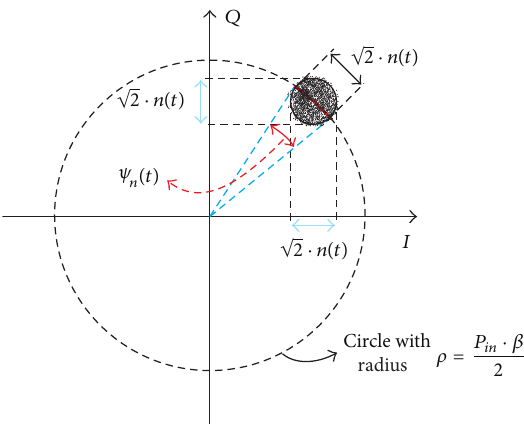
Figure 6: Influence of the internal noise in ̃𝜂 𝑛 (𝑡)